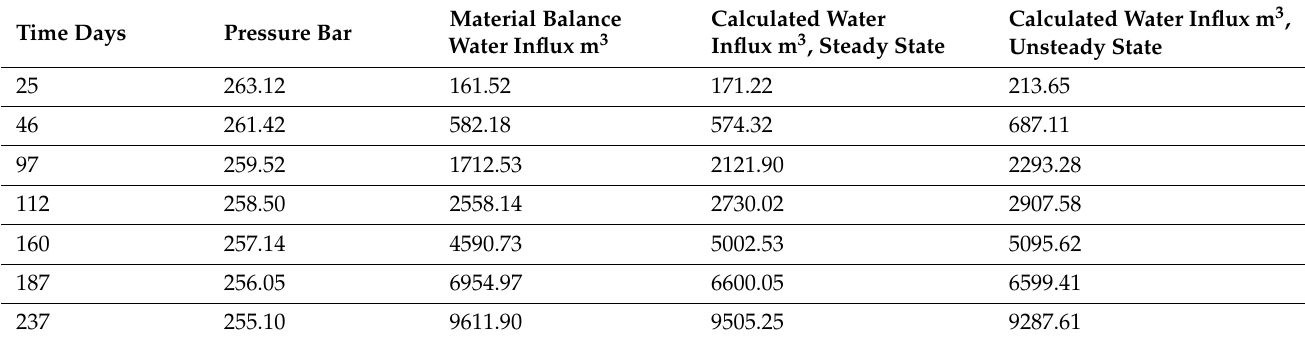
Table 8. Results of water influx match for Shueib